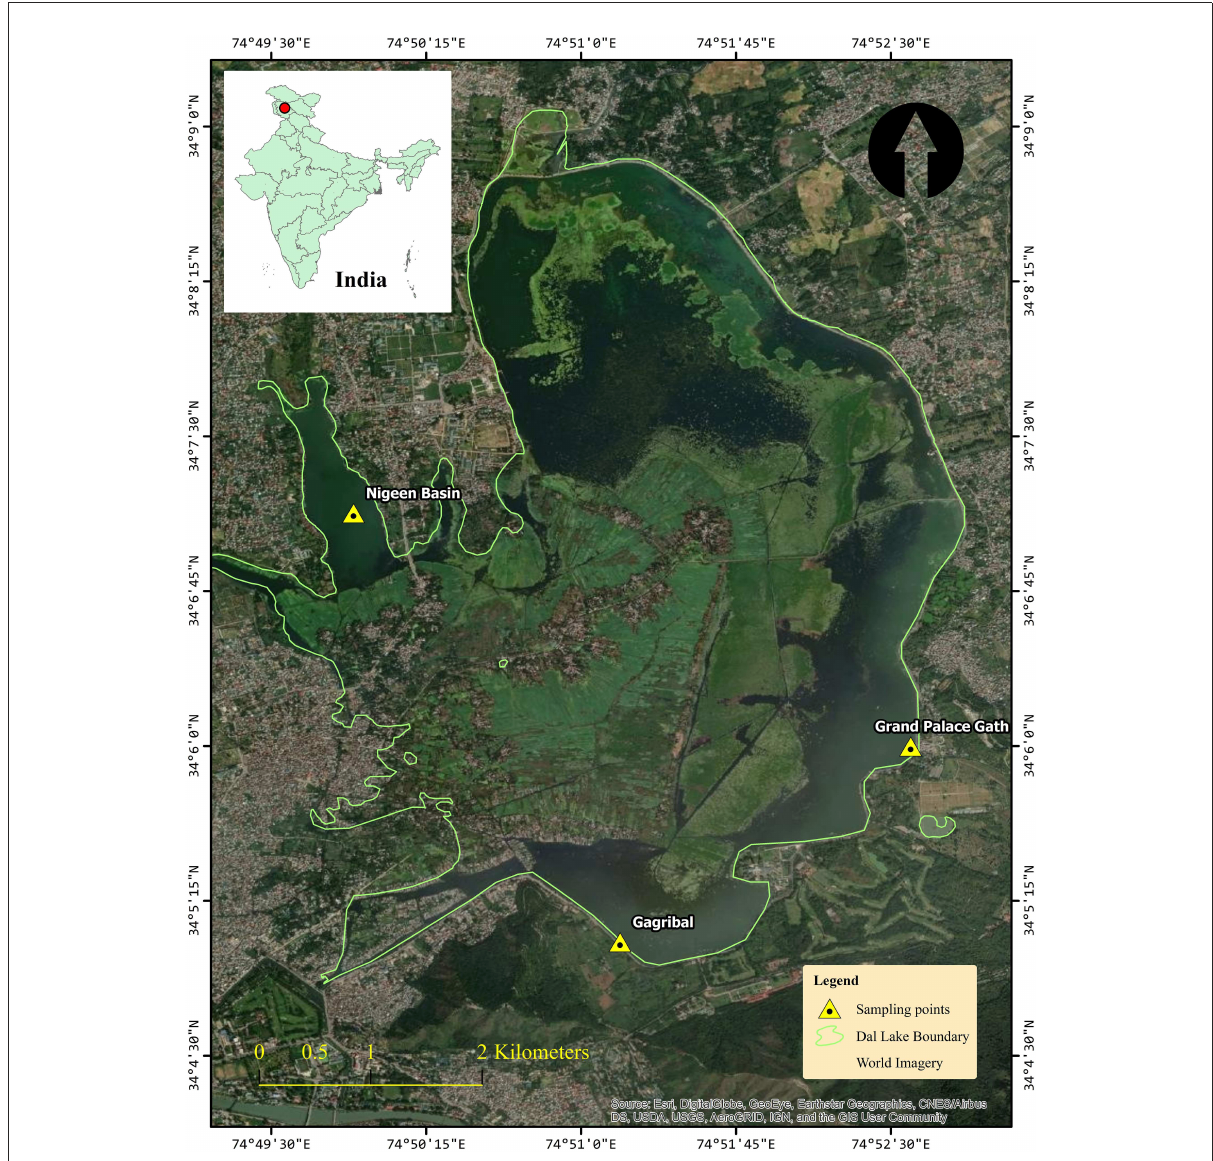
FIGURE1 Study Map and locations of the Dal Lake showing the three sampling sites, Grand Palace Gath (Site 1), Nigeen basin (Site 2), and Gagribal basin (Site 3).